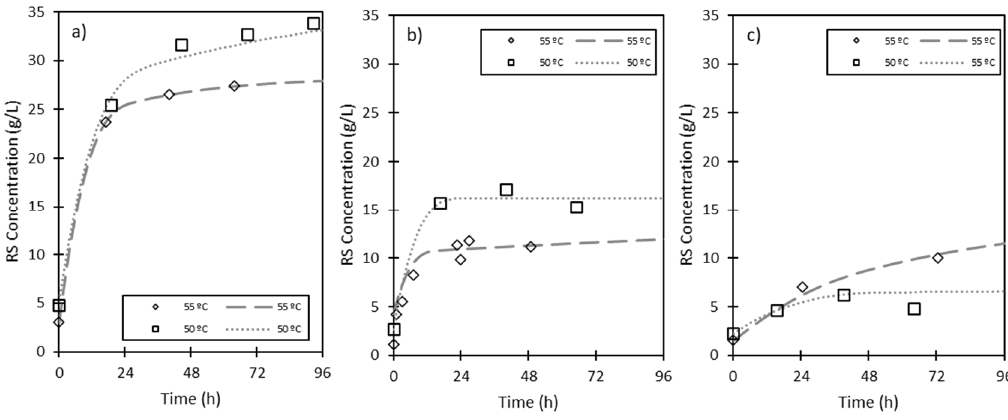
Figure 2. Evolution of reducing sugar (RS) concentration through hydrolysis time fresh ESBPPs in 300 mL of citrate ‐ phosphate buffer (pH 5, 0.05 M). Effect of temperature (T) with various fermented to fresh solid ratios (FFRs): ( a ) 5:30, ( b ) 15:15, and ( c ) 30:0. Table 2. E ff ect of temperature (T) with various FFRs (5:30, 15:15, and 30:0). G o : initial